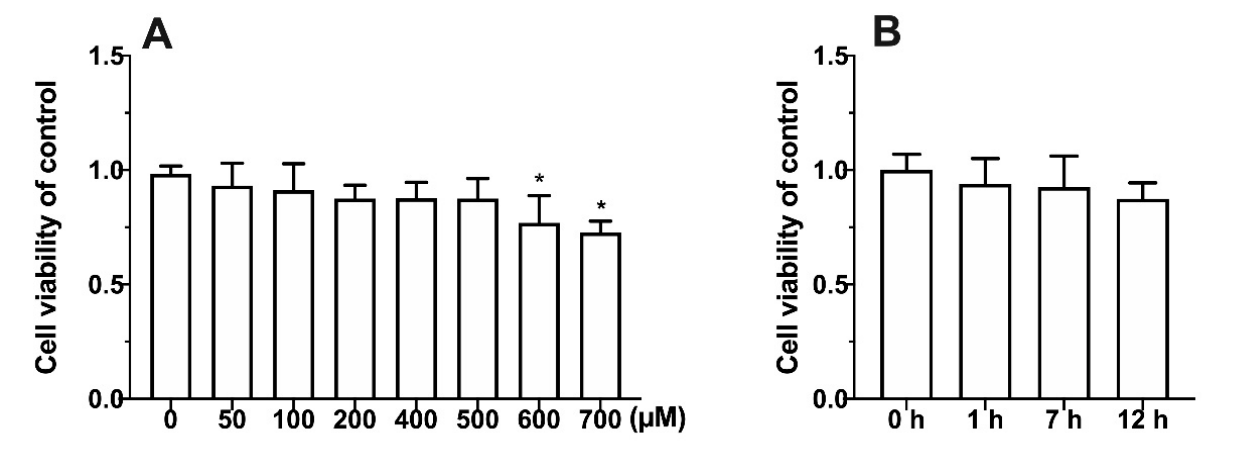
Figure 1. Effect of different concentrations ( A ) and induction time ( B ) of metabolic inhibitors on cell relative survival rate. Values represent means ± SD (n ≥ 6). * p < 0.05 compared with the control group.